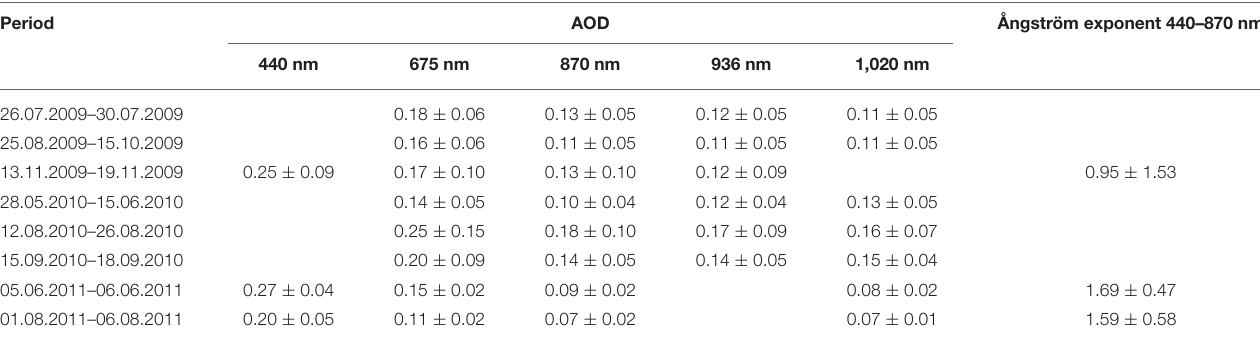
TABLE 3 | Aerosol characteristics in the atmosphere over